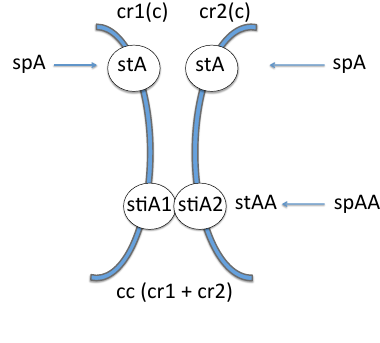
Figure 15: Reaction: spA(cr1) + spA(cr2) –>